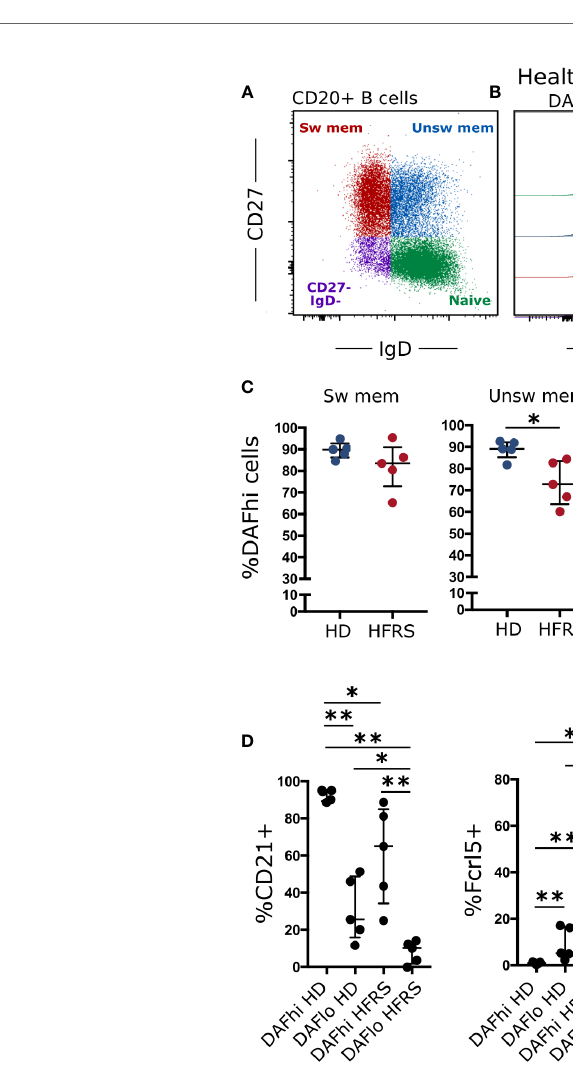
FIGURE 1 | DAF expression on circulating B cells is decreased during virus infection. (A) Flow cytometric gating to discriminate Naïve (CD27 − IgD + ), unswitched memory (unsw mem, CD27 + IgD + ), switched memory (sw mem, CD27 + IgD − ), and CD27- IgD- CD20 + B cells. (B) Representative histogram plots of DAF expression on B cell subsets in circulation of healthy controls (middle) or HFRS patients (right). (C) Quanti fi cation of DAF hi B cells in healthy donors or HFRS patients. *p < 0.05 by Wilcoxon signed-rank test. (D) Expression of CD21, Fcrl5, and CD95 in DAF hi and DAF lo CD27- IgD- B cells of HD or HFRS patients. N = 5 (healthy donors) and 5 (HFRS patients). *P < 0.05; **P < 0.01 by Wilcoxon signed-rank test. Bars show median and interquartile